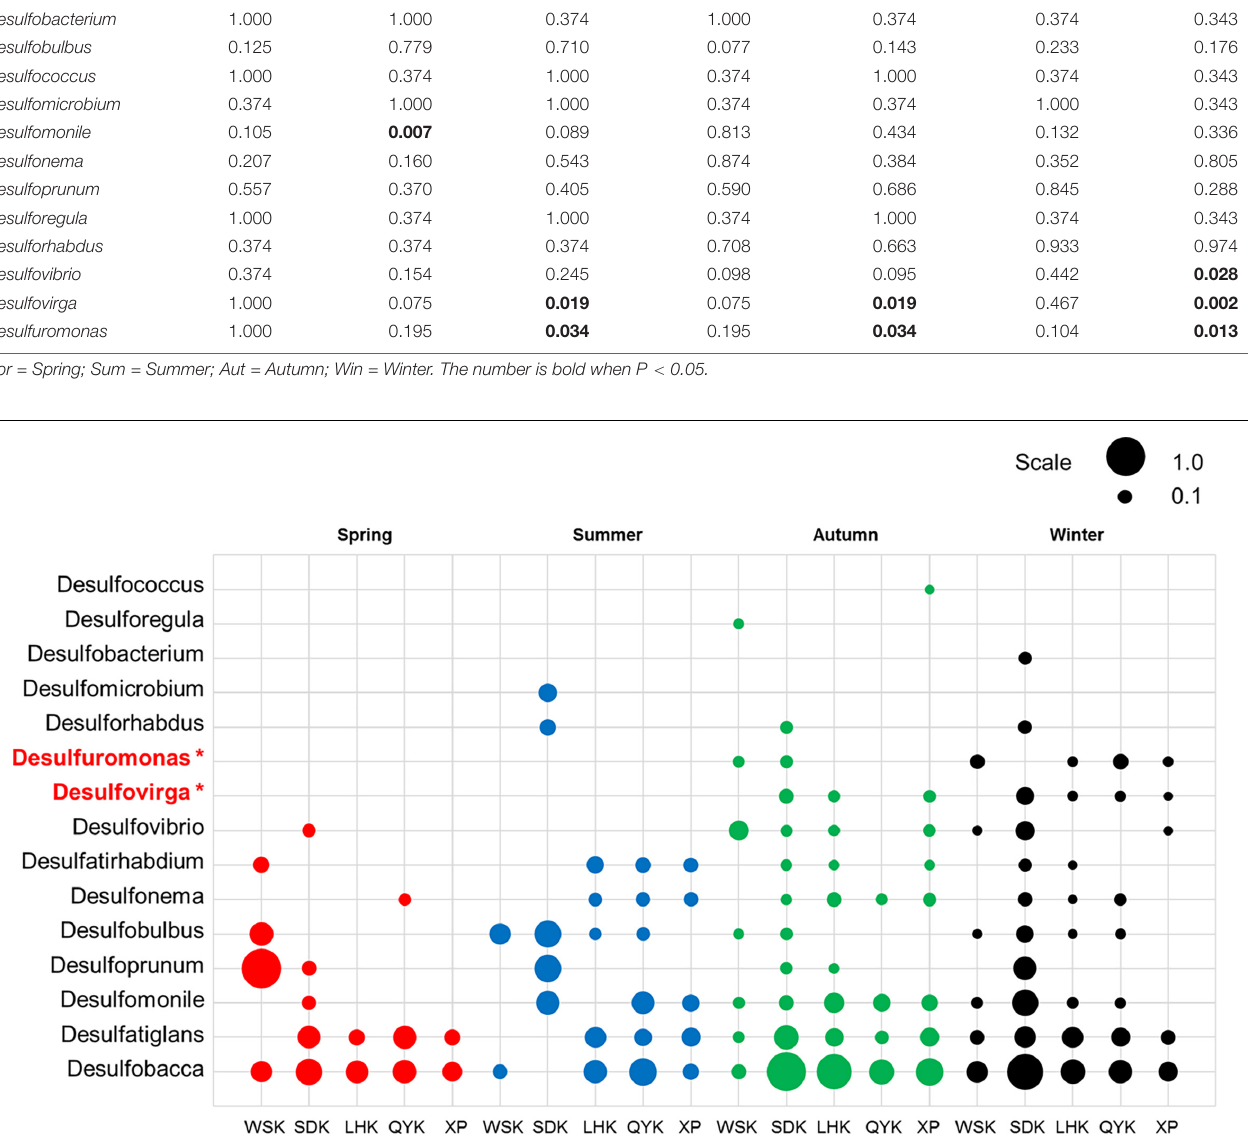
Dominant Class-Sediment Properties RDA As shown in Figure 6B , the two RDA axes explained 56.06% (51.47% and 4.59% for axes 1 and 2, respectively) of the